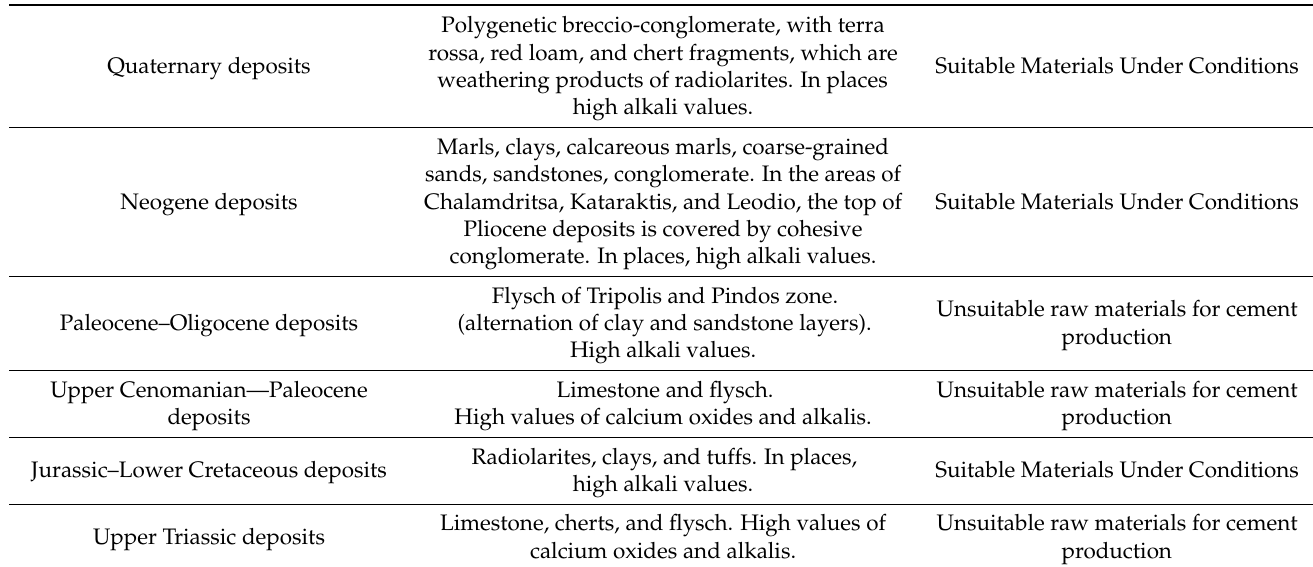
Table 2. Classification of the geological formations that appear in the wider area of the Prefecture of Achaia, in terms of their suitability as raw materials for the production of low alkali cement. Stratigraphic column homogenized based on the geological maps of IGME (sheets “Patrai” [9] and “Khalandritsa” [10], scale 1:50,000). Polygenetic breccio-conglomerate, with terra rossa, red loam, and chert fragments, which are Suitable Materials Under Conditions Quaternary deposits weathering products of radiolarites. In places high alkali values. Marls, clays, calcareous marls, coarse-grained sands, sandstones, conglomerate. In the areas of Neogene deposits Chalamdritsa, Kataraktis, and Leodio, the top of Suitable Materials Under Conditions Pliocene deposits is covered by cohesive conglomerate. In places, high alkali values.